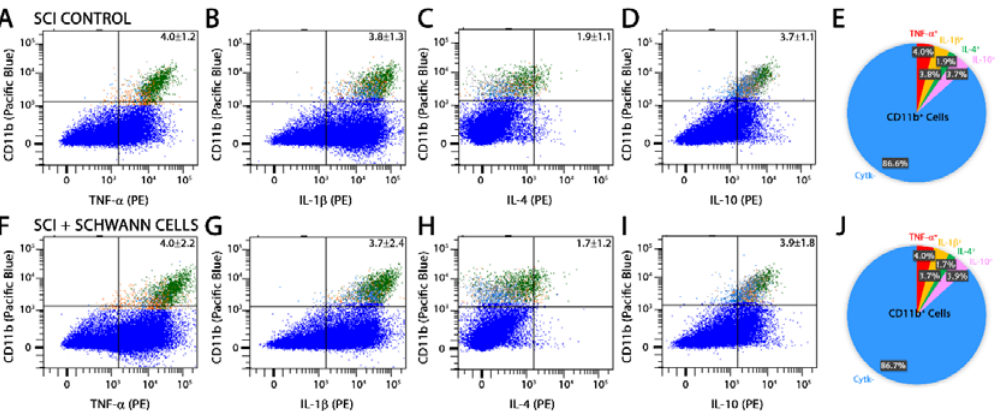
Figure 5. Cytokine profile of CD11b + cells is unaltered by SC implants after SCI. Representative images of flow cytometry analysis and pie charts of CD11b population dynamics at 14 days post-injury (7 days post-transplantation) show that CD11b immune cells have unaltered expression of pro- (TNF- α , IL-1 β ) and anti-inflammatory (IL-4, IL-10) cytokines comparatively among SCI controls ( A – E ) and SC-transplanted groups ( F – J ). Results are expressed as mean ± SD. For panels ( A – D , F – I ) the blue dots represent the cell population that were CD11b − or did not express the selected cytokines, whereas the green dots represent the CD11b + population that expressed CD11b and the cytokine of interest (top right quadrant).